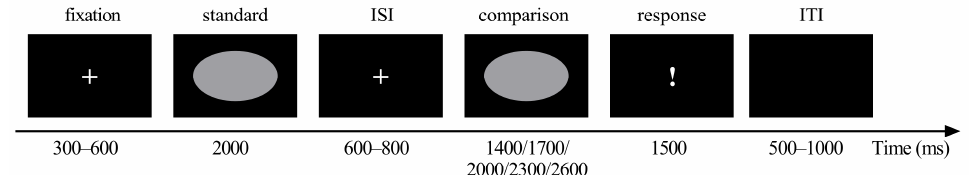
Figure 4. A depiction of the supra-second temporal discrimination task in Experiment 2. ISI: inter- stimulus interval; ITI: inter-trial interval.